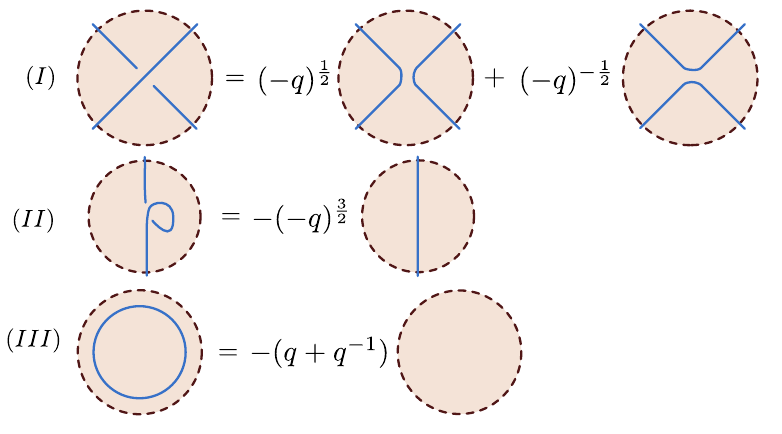
Figure 77 . Skein relations de(cid:12)ning Sk( M; sl